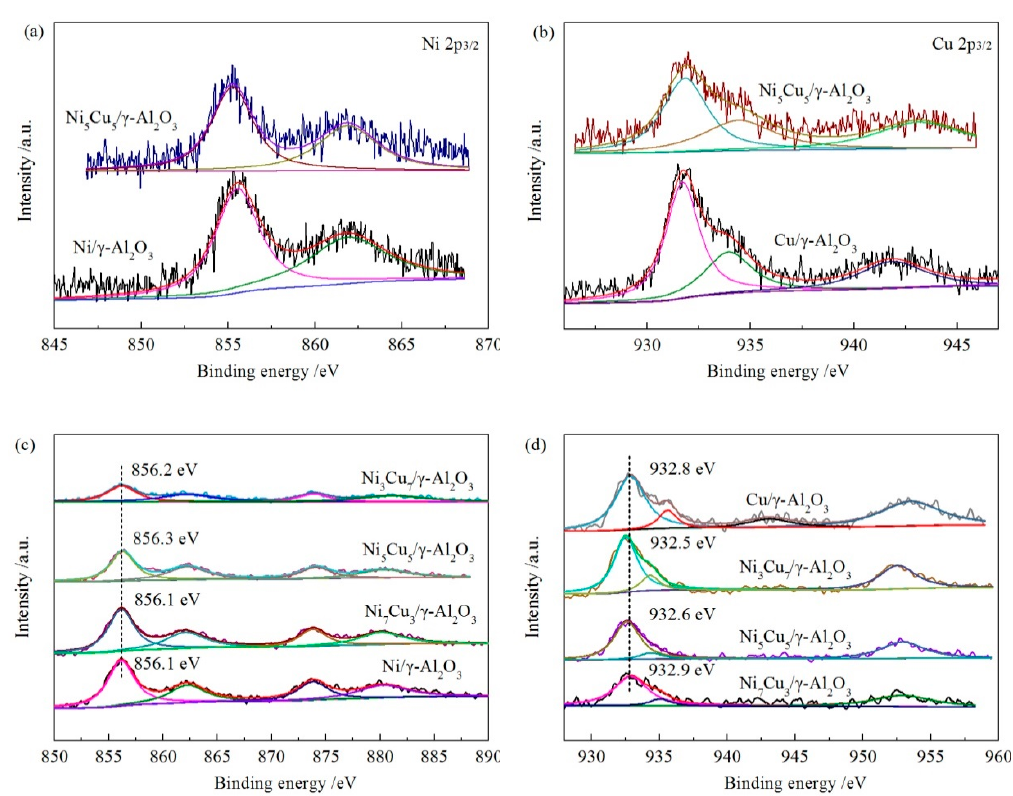
Figure 4. X-ray photoelectron spectroscopy (XPS) analysis of the ( a , b ) fresh and ( c , d ) spent catalysts: ( a , c ) Ni 2p; ( b , d ) Cu 2p